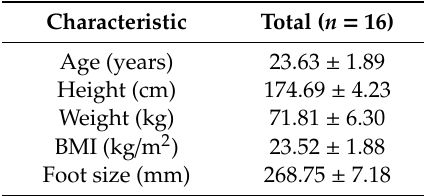
Table 1. Baseline characteristics of the participants.